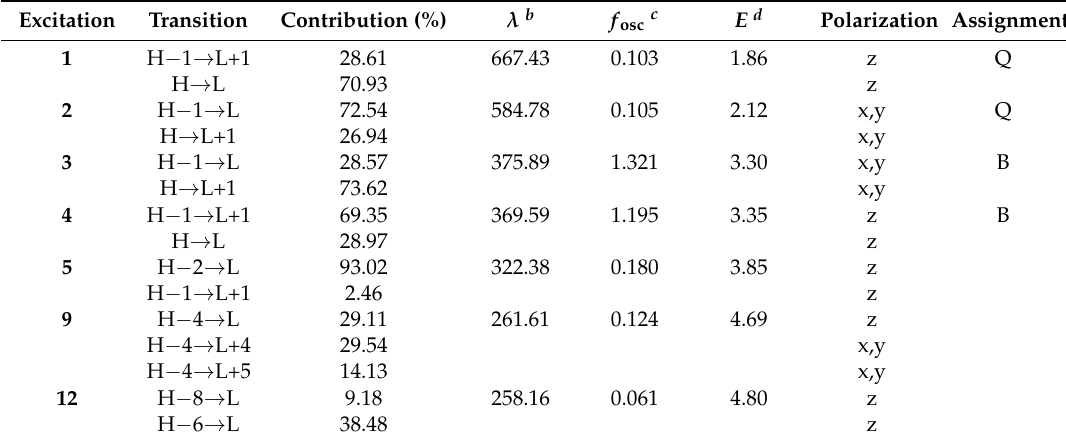
Table 6. Properties of the main electronic transitions of neutral unsubstituted (22)isosmaragdyrin ( 22I ) a